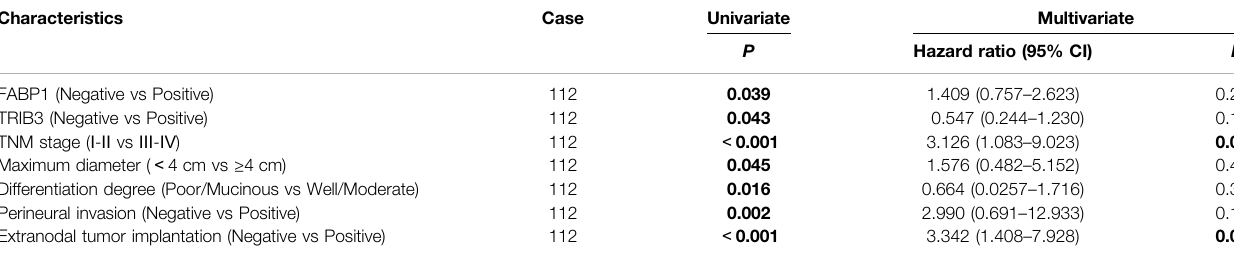
TABLE 2 | Correlation between the expression of FABP1 and TRIB3 and survival in GC. Characteristics